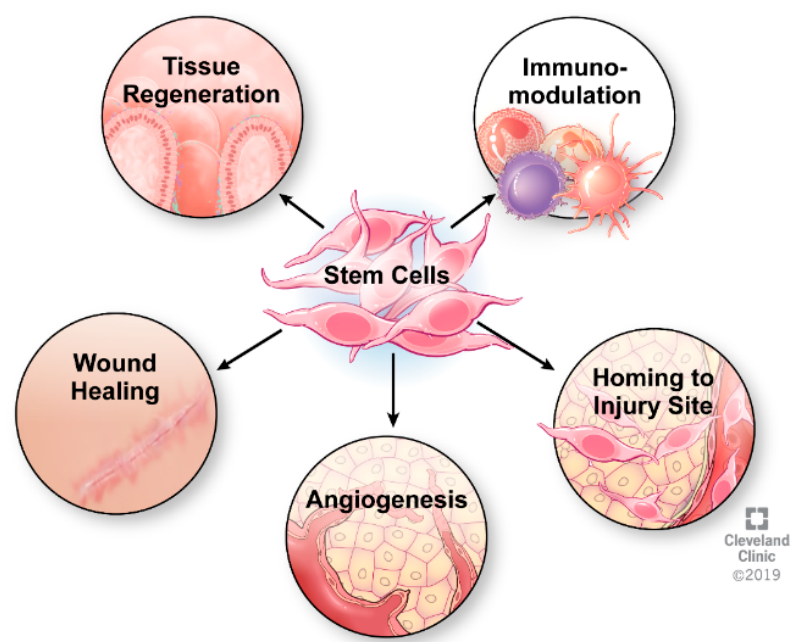
Figure 1. Mechanism of action of MSCs (courtesy of Cleveland Clinic, with permission).